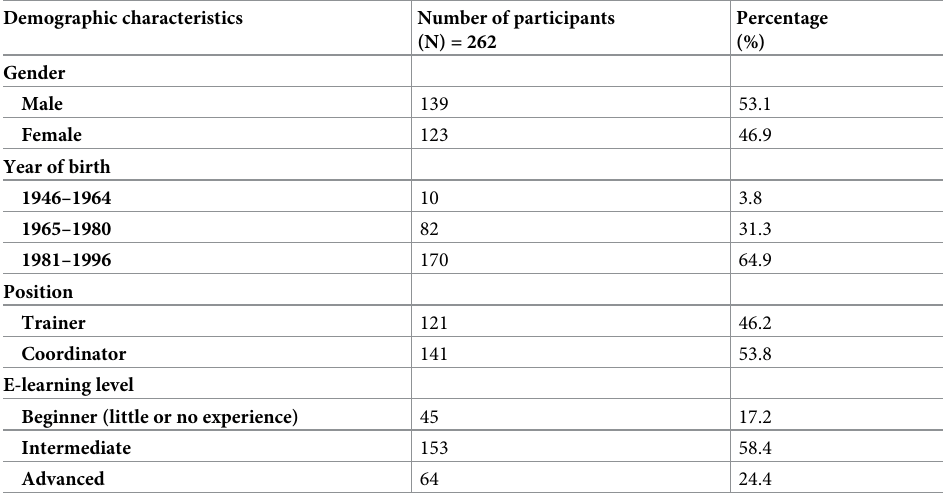
Table 1. Demographic characteristics of the participants.